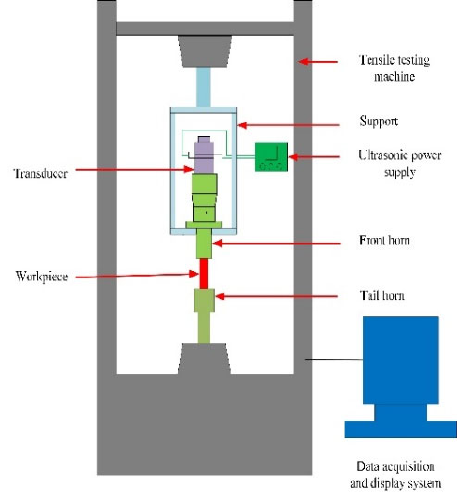
Figure 14. The ultrasonic tensile resonance system.